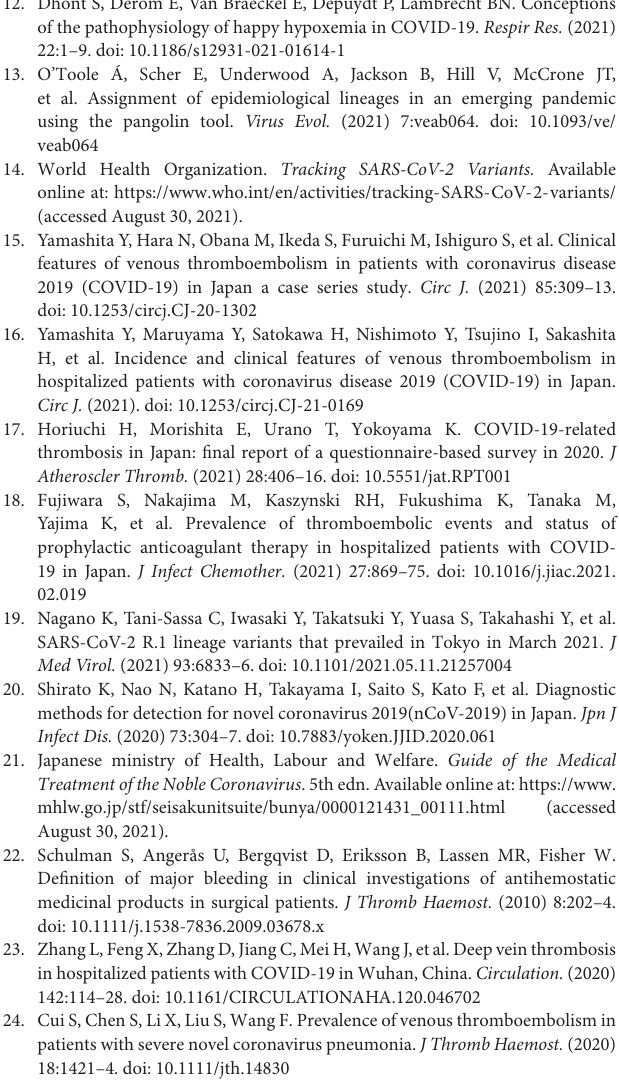
Supplementary Figure 2 | Sequential changes of the biomarkers before the development of thrombosis in the seven cases whose respiratory conditions were ameliorated. Each graph indicated the sequential change of individual biomarkers until the day of thrombotic events. The box-whisker plot indicated median and upper/lower quartile of the data of nine patients complicated with thrombosis whose respiratory conditions were ameliorated within a week. Supplementary Table 1 | Baseline characteristics of the patients in our cohort. SD, standard deviation; COPD, chronic obstructive pulmonary disease. Supplementary Table 2 | Detail pattern of thrombosis complicated in the individual cases with COVID-19. DVT, Deep vein thrombosis; PE, Pulmonary † embolism; PCI, Percutaneous coronary intervention. Distal or proximal DVT was defined as whether thromboses were identified in the calf vein or more proximal deep veins (59). In terms of severity of PE, massive, sub-massive, or non-massive was defined as whether PE with sustained hypotension, PE with normotension but with either right ventricular dysfunction and myocardial necrosis, or PE with the absence of clinical markers of adverse prognosis that define massive or sub-massive PE